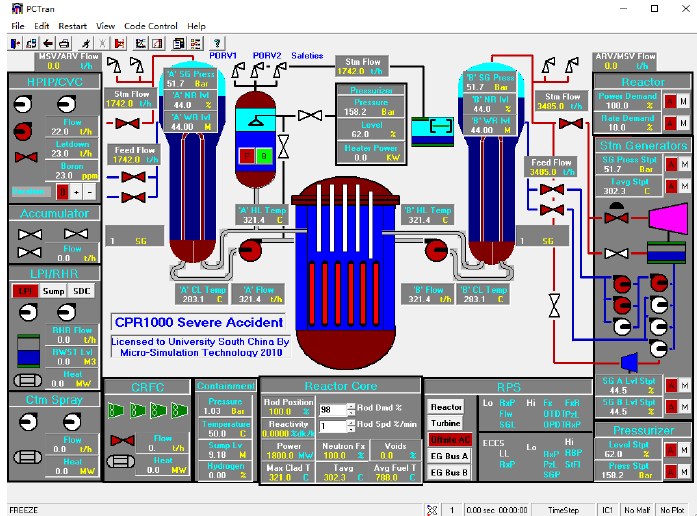
Figure 1. PCTRAN main control